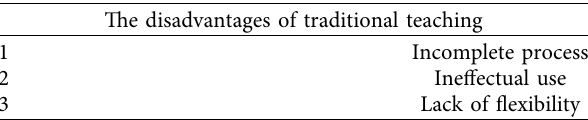
Figure 7: Multimedia is part of the network technology. Table 3: The disadvantages of traditional